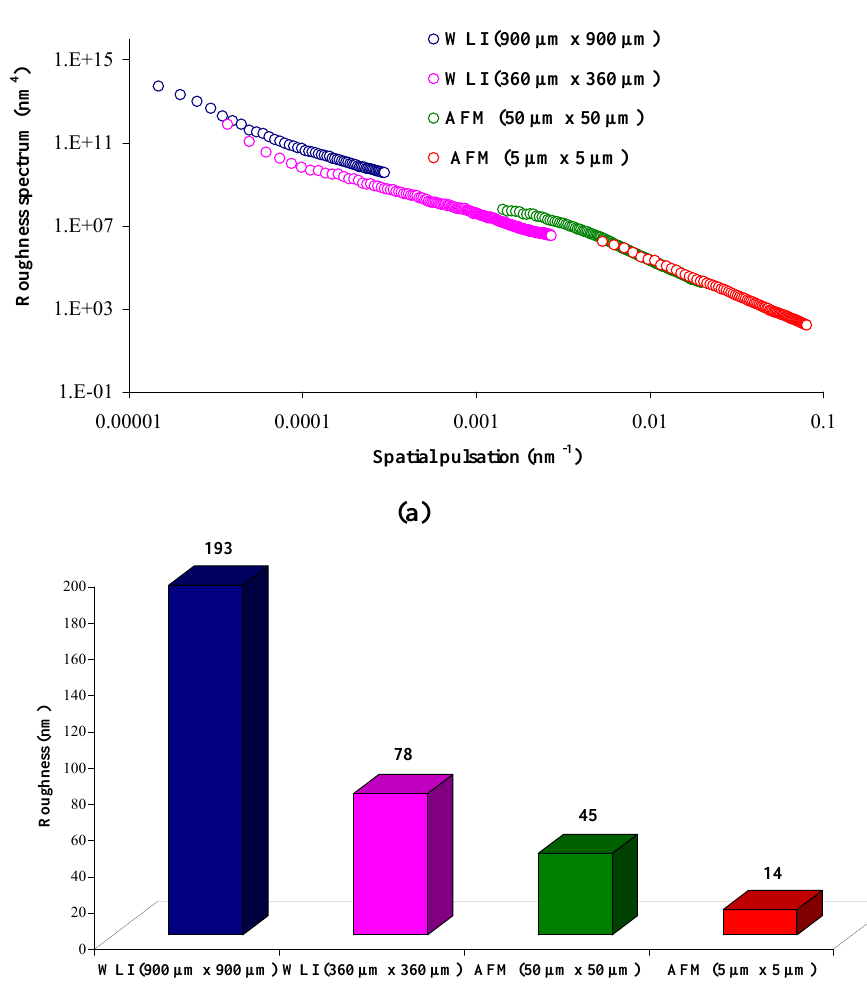
Figure 1. Roughness spectrum (a) and evolution of the roughness (b) for the 100 kDa flat sheet membrane by White Light Interferometry (WLI) and Atomic Force Microscopy